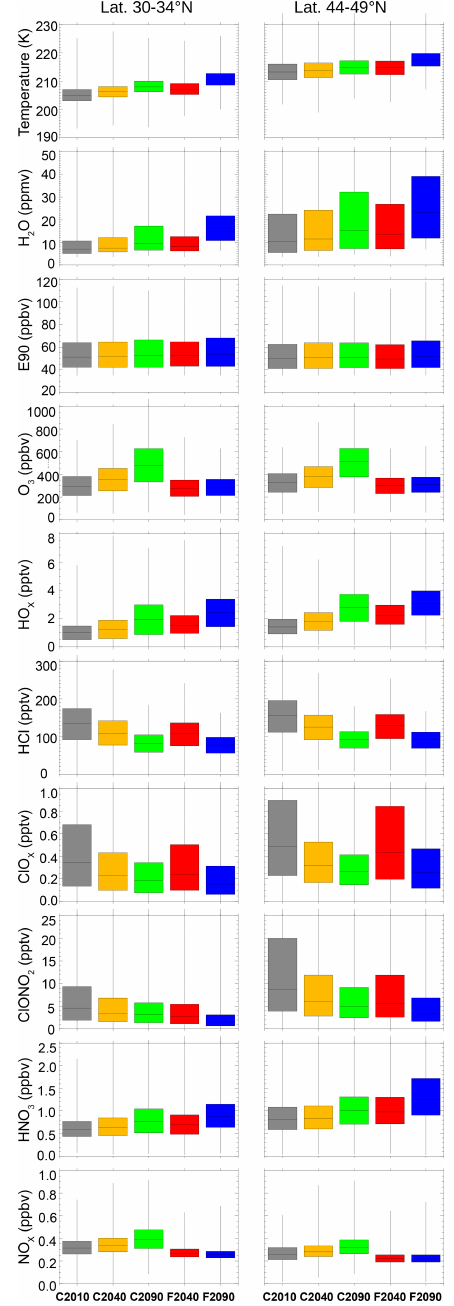
Figure 5. Distribution of temperatures and several trace gas mixing ratios in the GLENS mixing layer for case C2010 and future sce- narios considering both global warming (C2040, C2090) and sul- fate geoengineering (F2040, F2090) (see Table 1). The frequency distribution is illustrated as box plots, where the upper and lower quartile (75% and 25%) of the data set is marked by the upper and lower end of the box. The median of the temperature or mixing ratio values within the mixing layer is illustrated by the horizontal line in the box. Ends of vertical lines mark the minimum and the maximum value of the considered